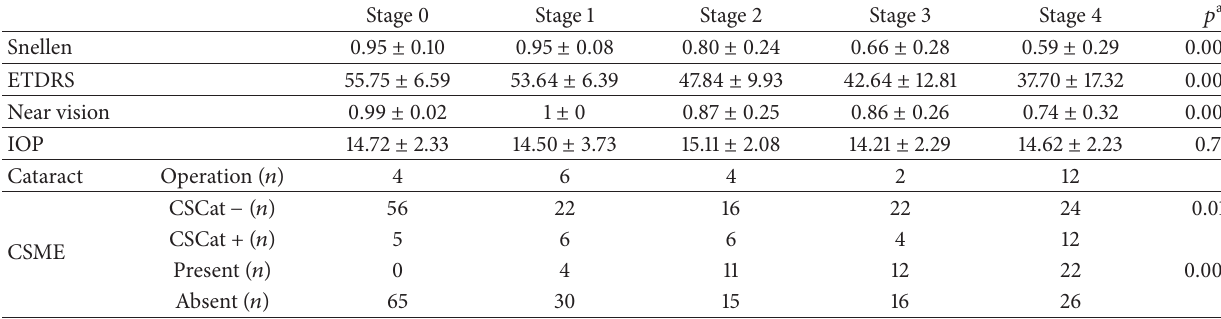
Table 4: Ophthalmologic findings of patients according to stages.